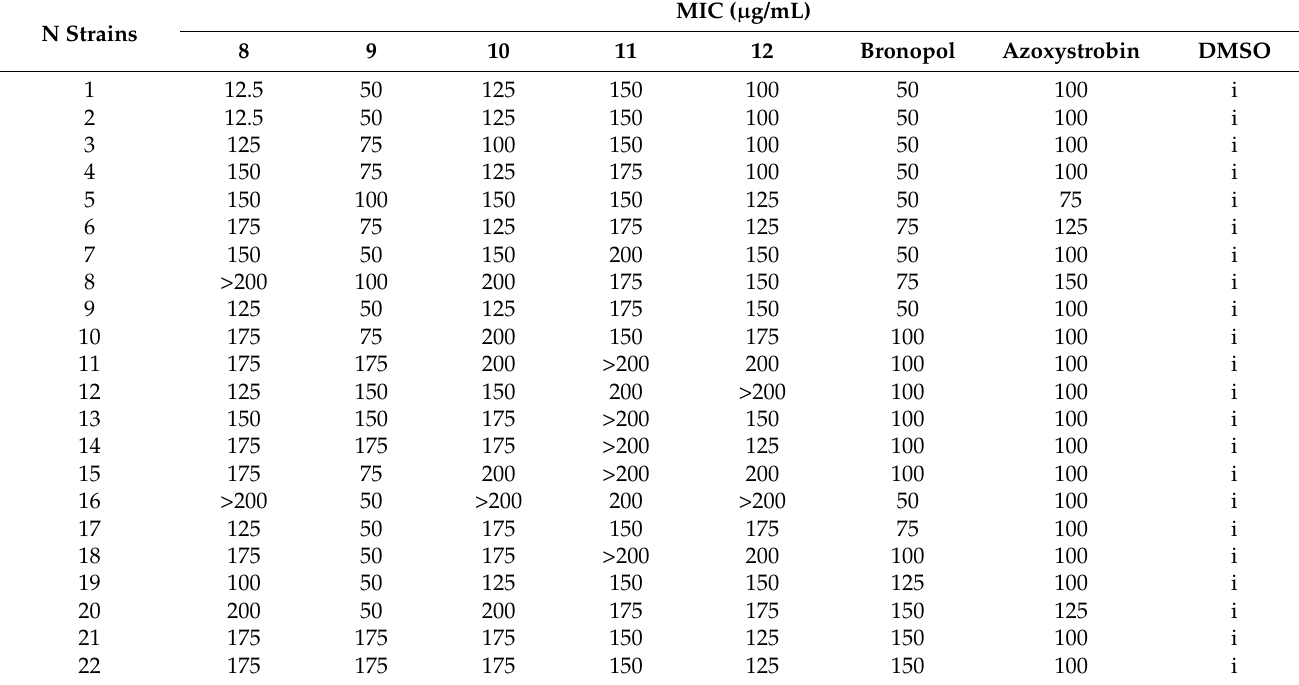
Table 3. MIC values a of compounds 8 – 12 against mycelium at 48